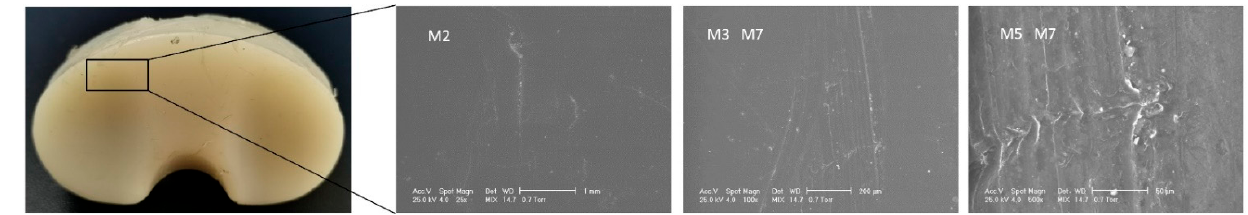
Figure 9. SEM images obtained for IT2 sample.